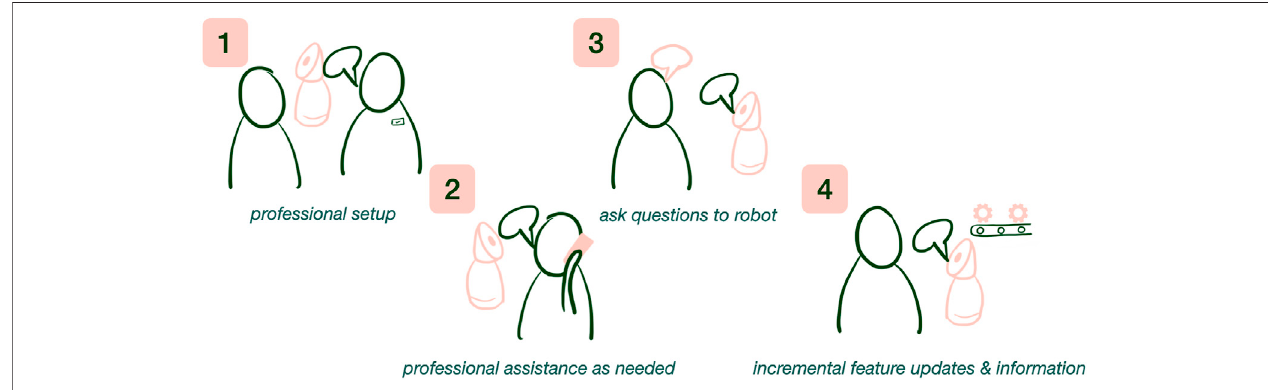
FIGURE 2 | Installation methods recommended by participants including four options: expert setup and assistance, user setup with access to professional assistance, user setup with ability to ask questions to the robot, and robot incrementally introducing new features and supporting older adults using them.